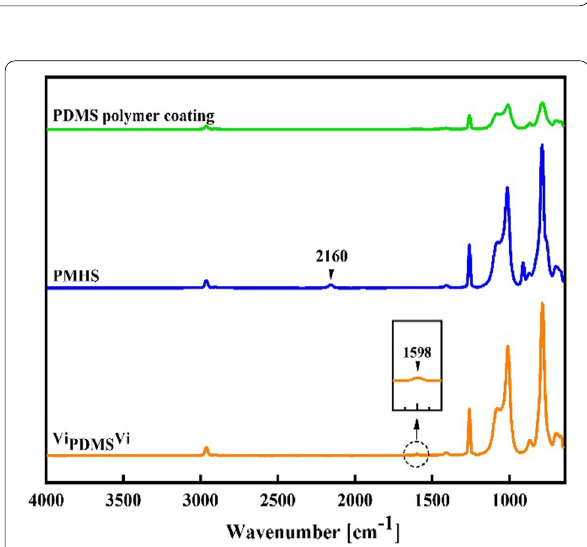
Fig. 3 FT-IR spectra of PDMS polymer, PMHS, and Vi PDMS